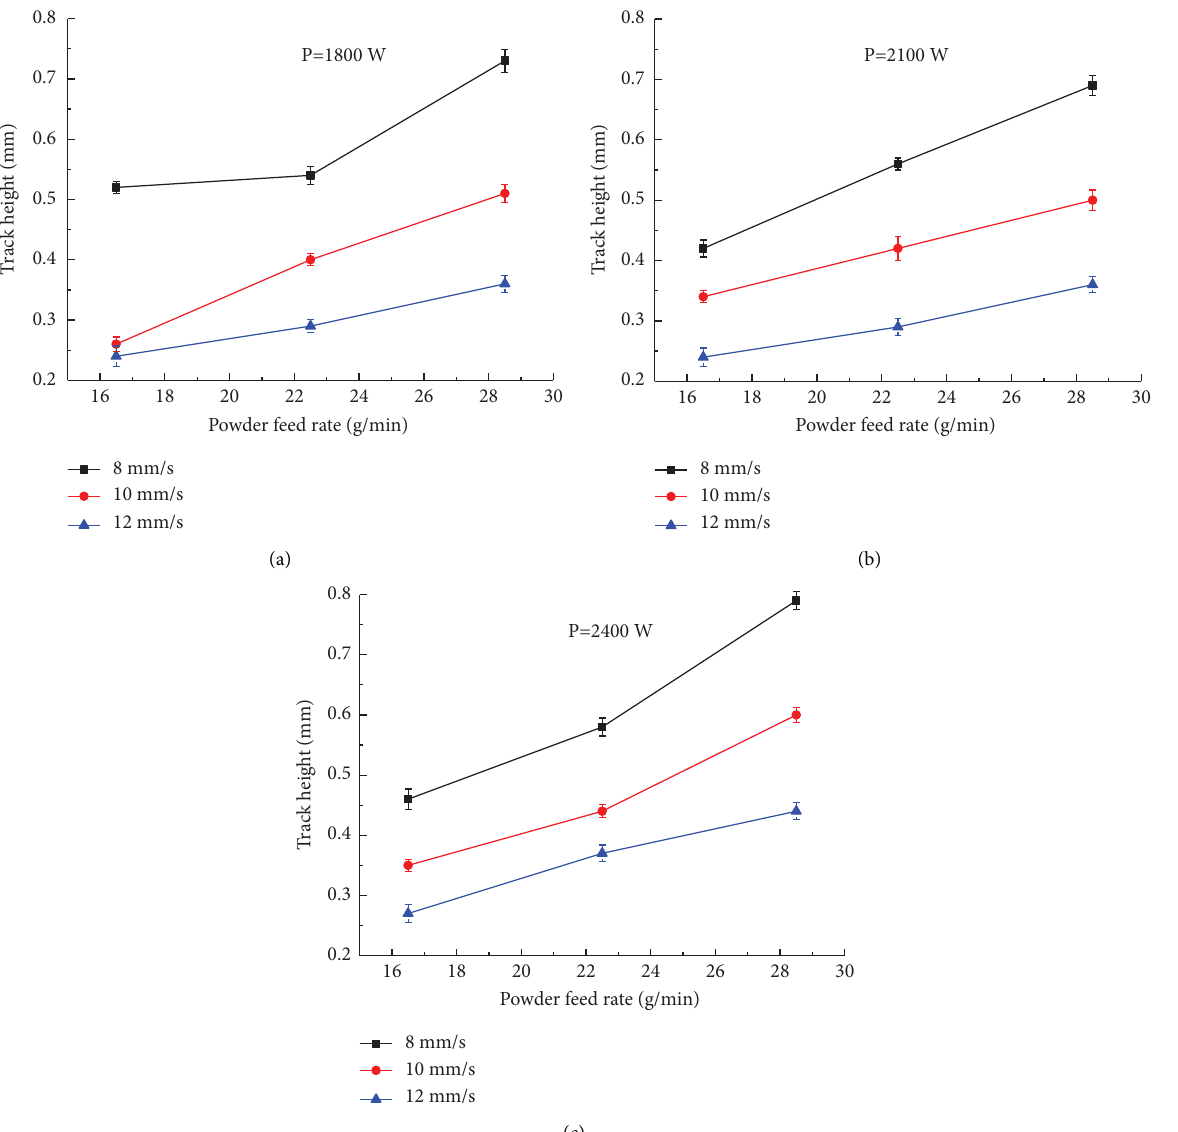
Figure 7: Variation of track height with powder feed rate and scan speed at given laser power. (a) P � 1800 W; (b) P � 2100 W; (c) P � 2400 W.